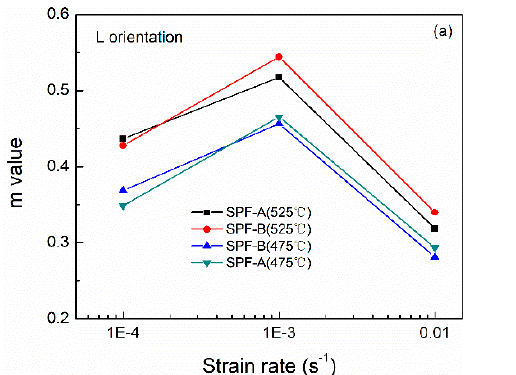
Figure 7. Strain rate sensitivity as a function of true strain at 475 °C [91].